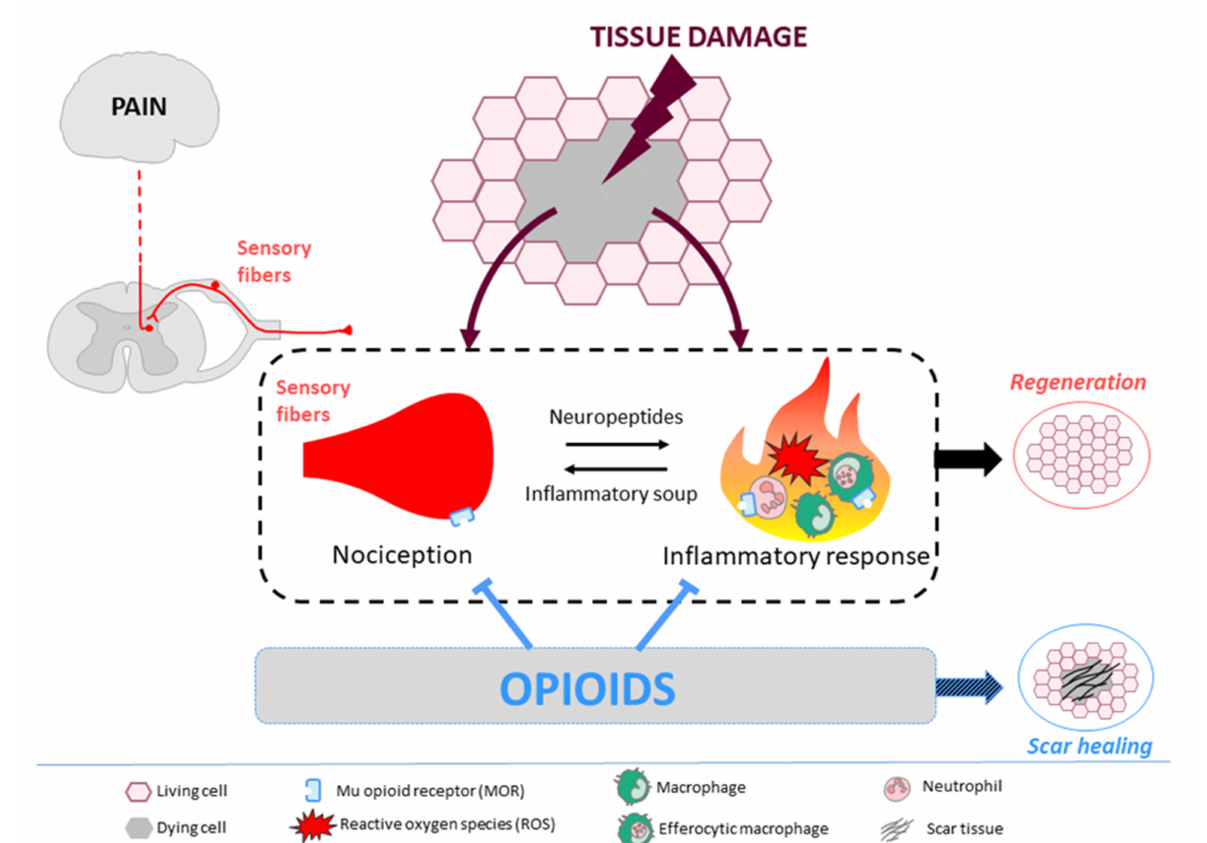
Figure 1. Schematic diagram illustrating the anti-regenerative effects of opioids during tissue